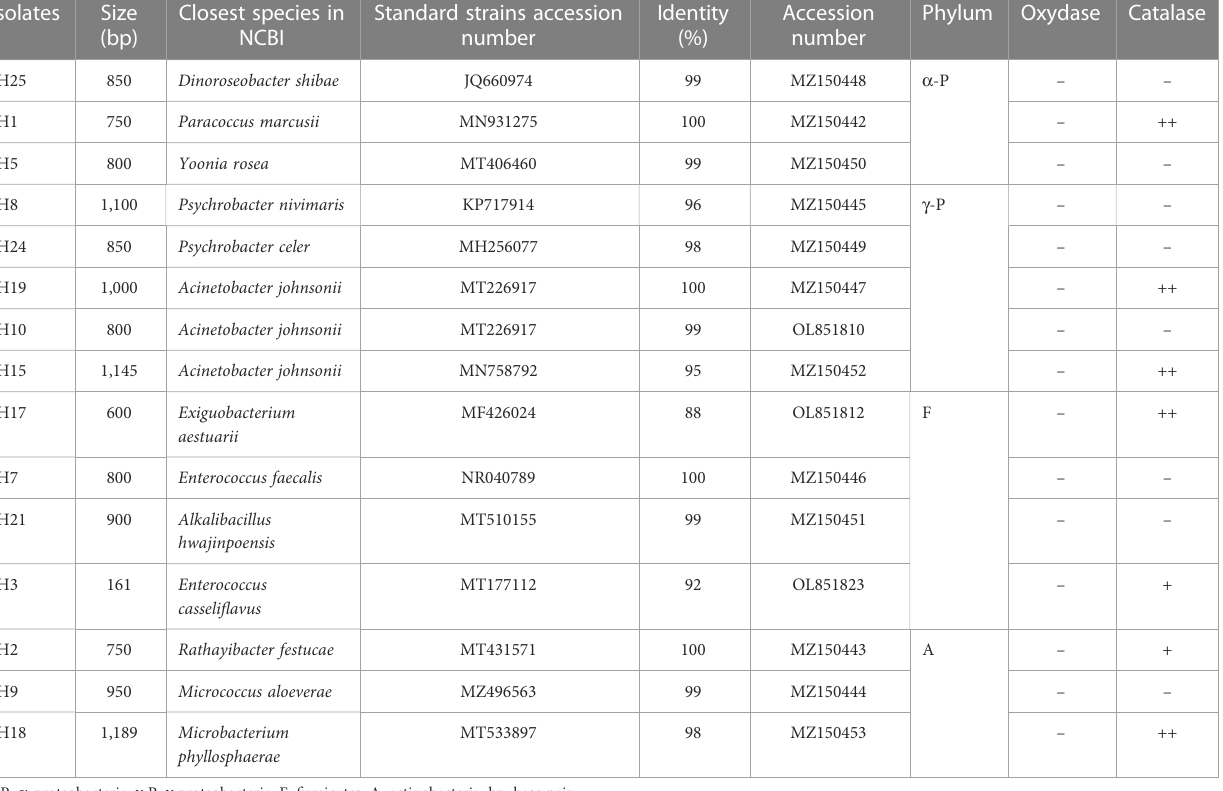
TABLE 1 Epibiotic bacteria isolated from the Ulva ohnoi surface.